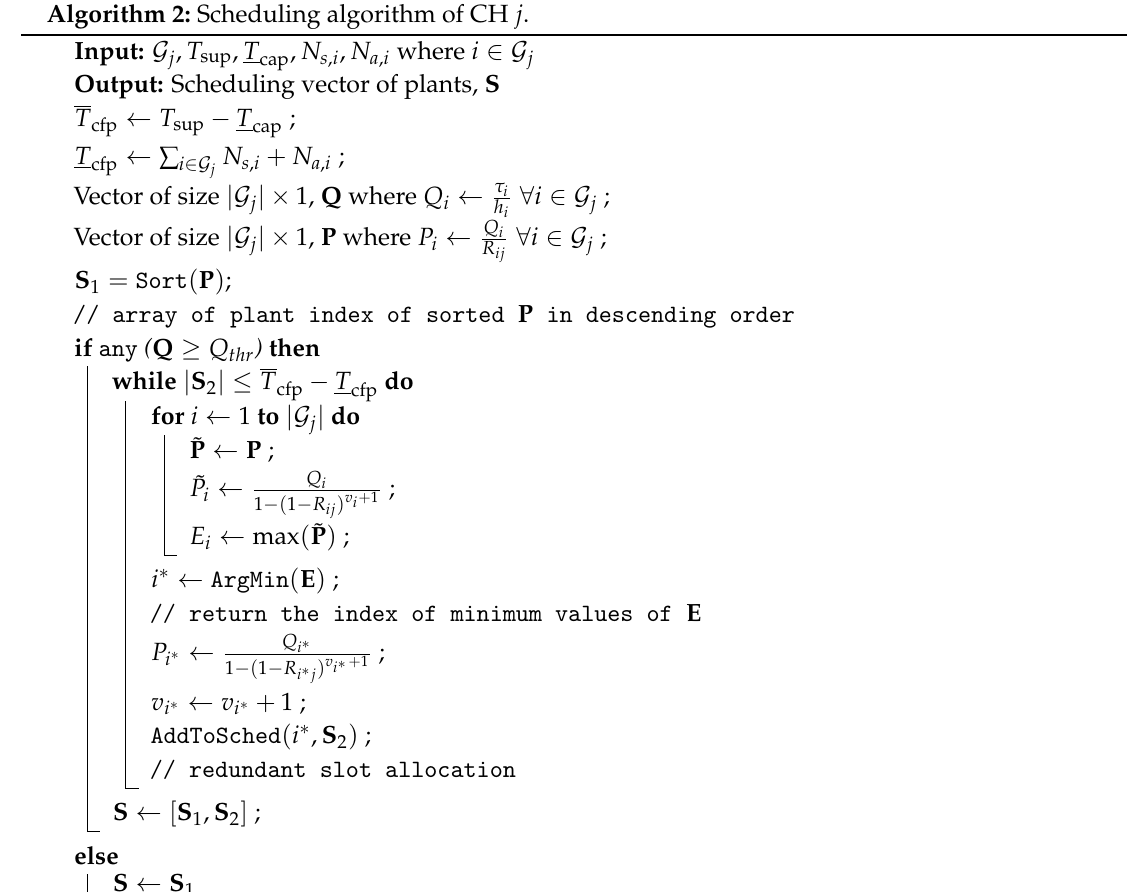
Algorithm 2: Scheduling algorithm of CH j